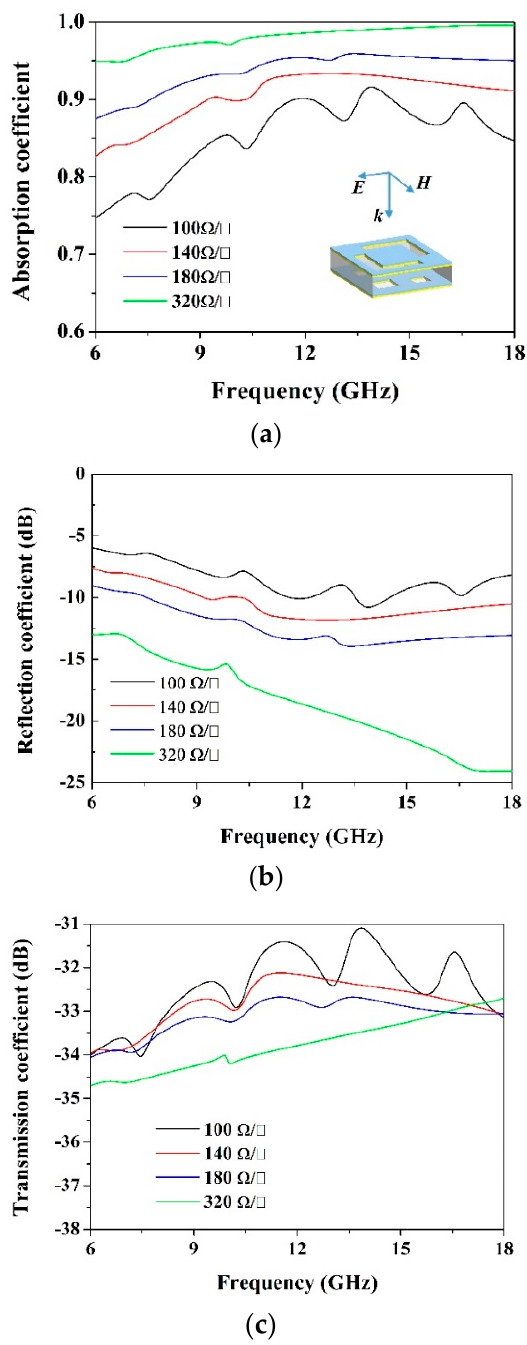
Figure 3. Absorption coefficients and reflection/transmission coefficients. ( a ) Absorption coefficients. ( b ) Reflection coefficients. ( c ) Transmission coefficients.